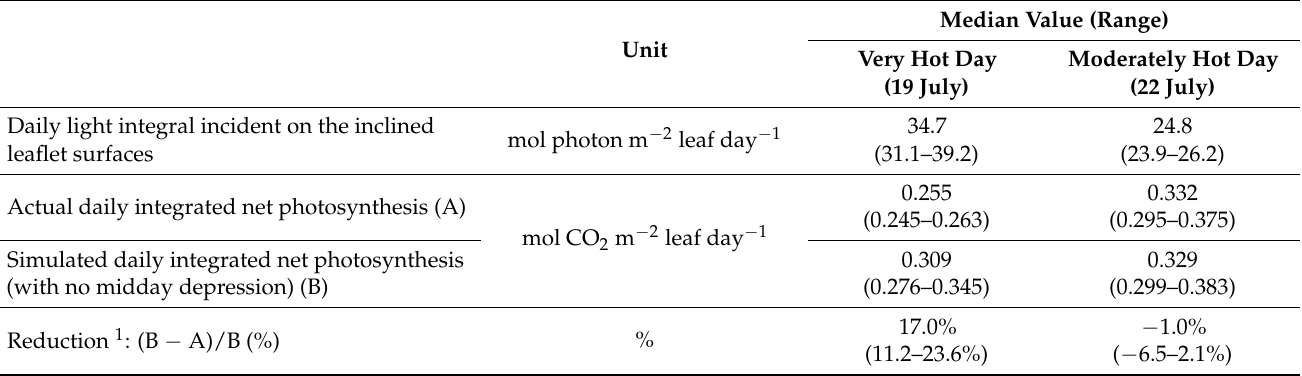
Table 1. Daily integrated